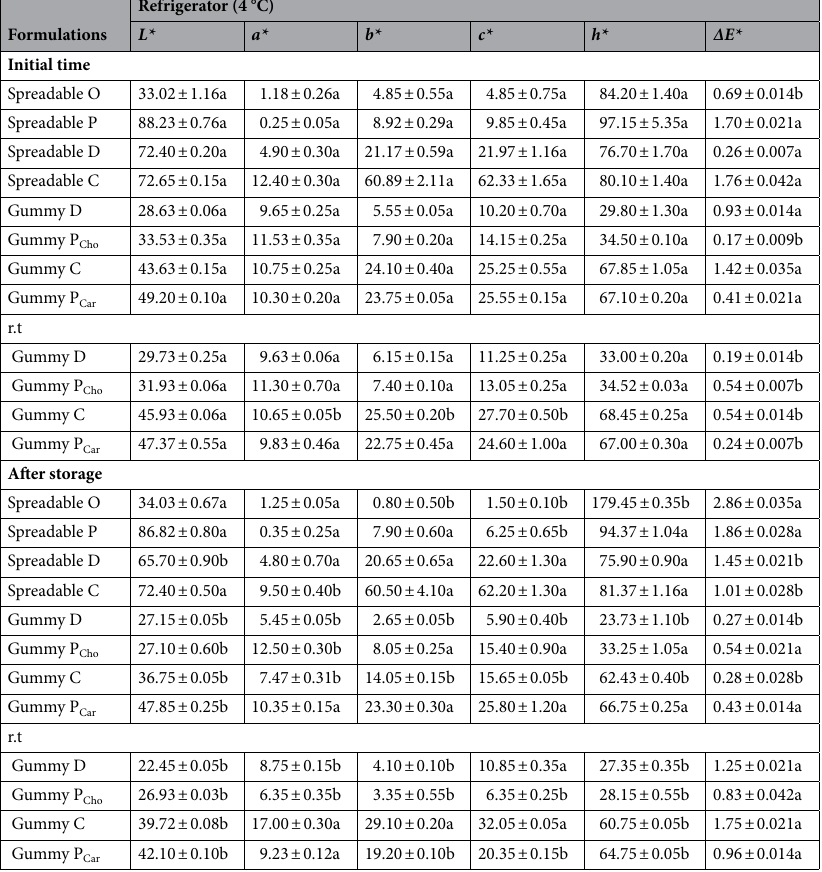
Table 4. Color characteristics of functional spreadable oleogels and gummy formulations stored at the initial time and after storage conditions (4 °C and r.t.). Columns with similar letters are not statistically different according to DMRT (p ≤ 0.05). Statistical analysis was performed to distingue the significance at the initial time and after